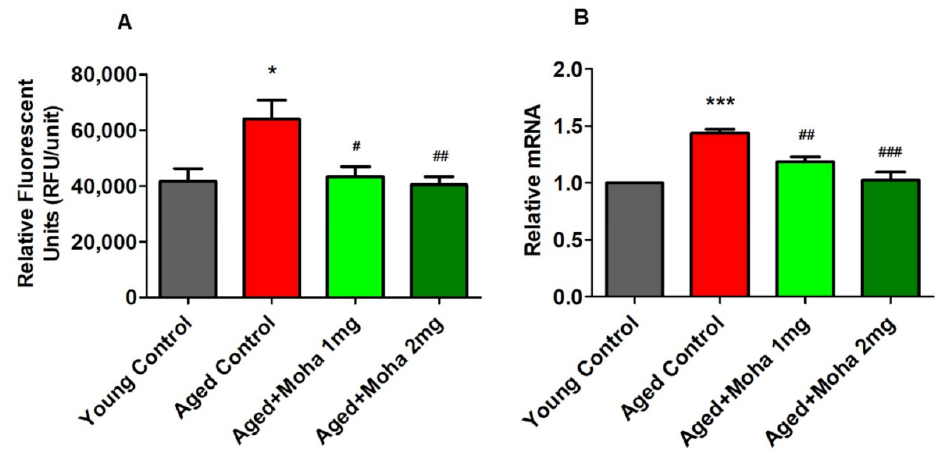
Figure 6. Effects of mahanimbine on BACE-1 in aging mouse brain. ( A ) Comparison of BACE-1 activity. ( B ) Comparison of the expression of the BACE-1 gene. Mahanimbine administration attenuated BACE-1 activity in aged mouse brain. All data were expressed as mean ± SEM (n = 6). One-way ANOVA ( F (3,20) = 5.805, p < 0.01 for BACE-1 activity and F (3,20) = 21.46, p < 0.001 for expression of BACE-1 gene) followed by Tukey–Kramer multiple comparisons test. * p < 0.05 and *** p < 0.001 in comparison with young control; # p < 0.05, ## p < 0.01, and ### p < 0.001 in comparison with aged